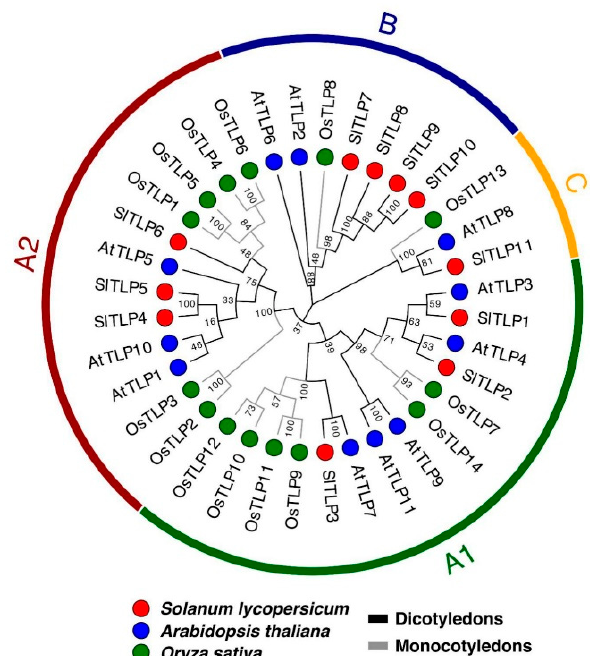
Figure 1. Neighbor-joining (NJ) tree of TLPs in Solanum lycopersicum, Arabidopsis thaliana and Oryza sativa (SlTLPs: TLPs in Solanum lycopersicum; AtTLPs: TLPs in Arabidopsis thaliana; OsTLPs: TLPs in Oryza sativa).